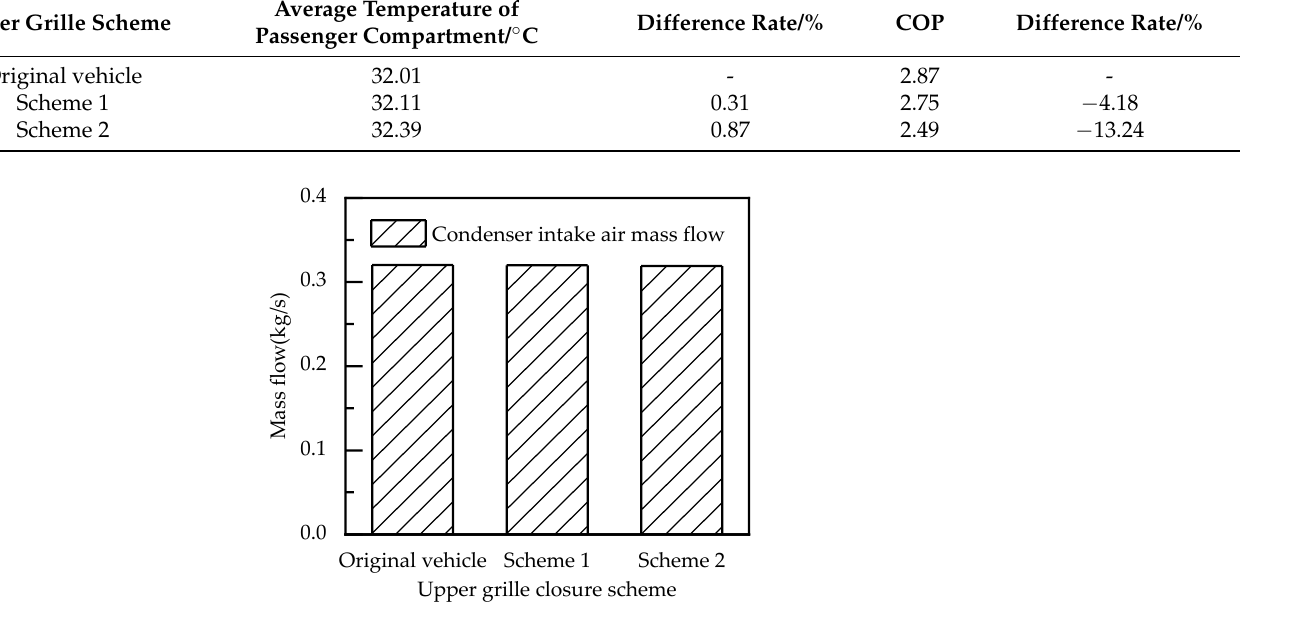
Figure 15. Comparisons of air side flow of the condenser under different upper grille schemes.